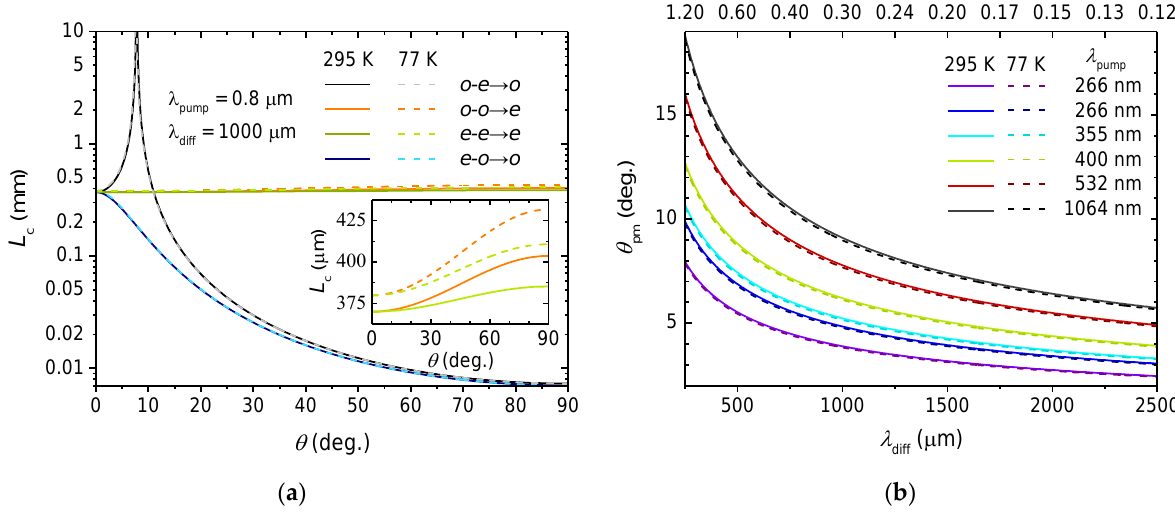
Figure 3. Phase-matching simulation: ( a ) dependence of the coherence length on the angle θ for four conversion types that resulted in THz wave generation in LB4. Pump wavelengths were in the vicinity of 0.8 μm, and the resulting wavelength was 1000 μm (0.3 THz). The inset shows an enlarged dependence for the o − o → e and e − e → e conversions types. ( b ) Phase-matching curves for the o − e → o conversion of various pump wavelengths to the sub-THz range.